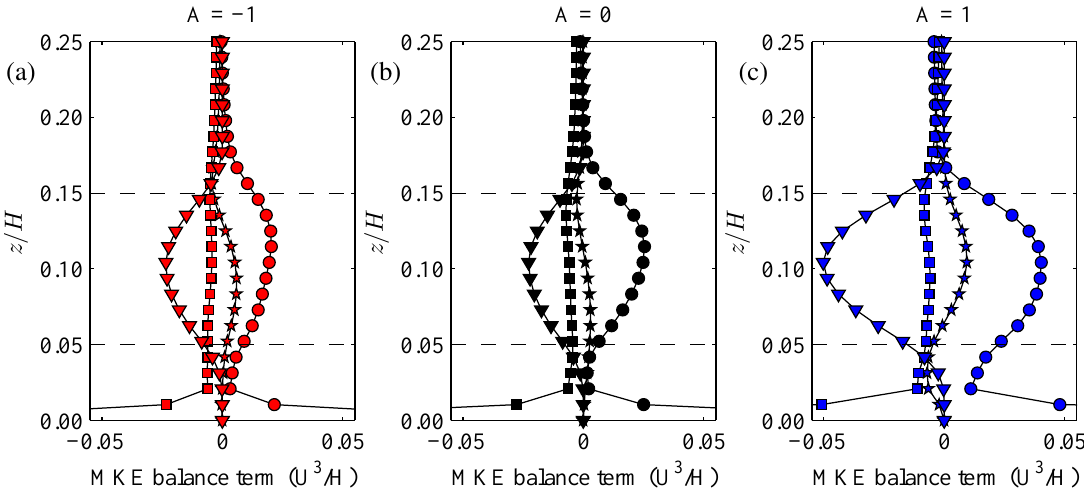
Figure 9. Horizontally-averaged terms in the MKE balance are shown as a function of height for three forcing cases: ( a ) A = − 1; ( b ) A = 0; and ( c ) A = 1. Each symbol represents the horizontal average of a single term in Equation (6): advection ( (cid:70) ); MKE flux ( • ); MKE dissipation ( (cid:4) ); and turbine power extraction ( (cid:72) ). The turbine rotors are located in the region between the dashed